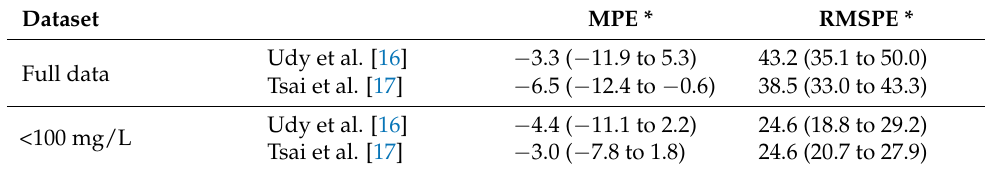
Table 4. Description of the predictive performance of the model.